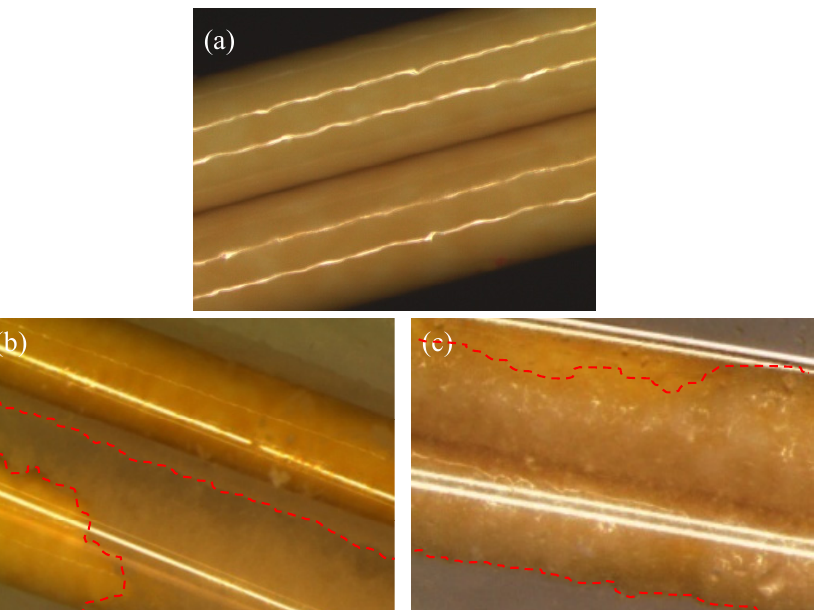
Figure 9. In situ observation of gypsum scaling on PBI/PES membranes. The yellow fiber is the PBI/PES membranes, and the white crystals are the gypsum crystals. ( a ) Clean membrane; ( b ) scaling at pH 3; and ( c ) scaling at pH 10. The percentage of surface coverage (the ratio of the membrane area scaled by gypsum over the total membrane area) on the membrane at pH 10 is higher than that at pH